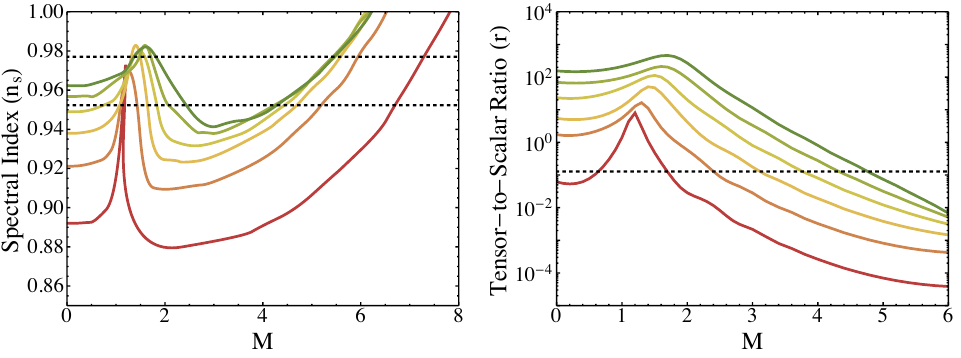
Figure 9 . The spectral index n s (left) and the tensor-to-scalar ratio r (right) as a function of the mass M for (cid:13) = 4 ; 5 ; 6 ; 7 ; 8 ; 9, color-coded from red to green. The horizontal black-dotted lines correspond to the Planck 2- (cid:27) bounds.